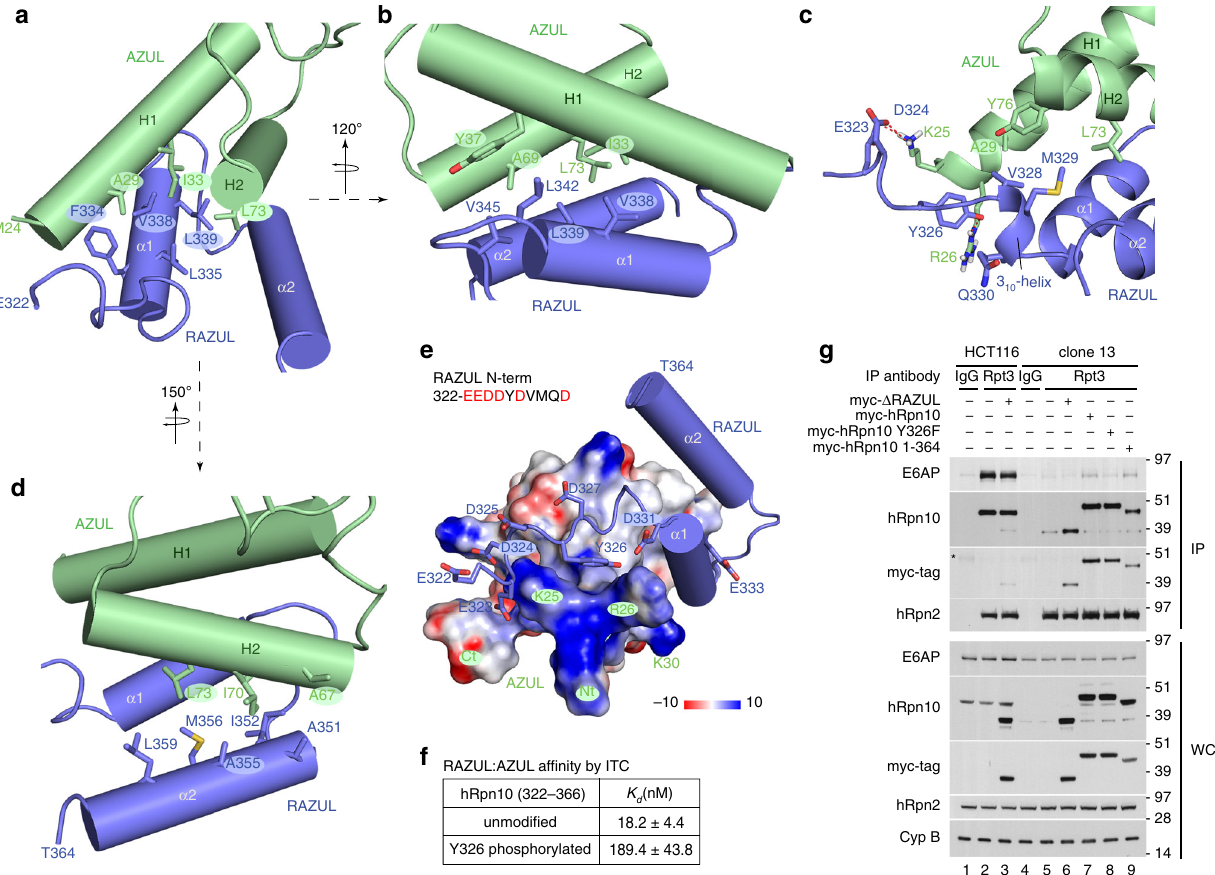
Fig. 6 RAZUL:AZUL forms an intermolecular 4-helix bundle. Regions displaying AZUL contacts with RAZUL α 1 ( a , b ), the 3 10 -helix ( c ), and α 2 ( d ) showing selected interacting sidechain atoms with oxygen, nitrogen, and sulfur colored red, blue, and yellow, respectively. The structure in c is displayed as a ribbon diagram to better view the 3 10 -helix with hydrogen bonds included as red dashed lines. The structures in a , b , and d depict helices as cylinders for simplicity. e Electrostatic surface diagram for AZUL to highlight acidic (red) and basic (blue) regions. The bound RAZUL is displayed with cylindrical helices and sticks for N-terminal acidic residues with oxygen colored red. f ITC analyses for AZUL-binding hRpn10 322 – 366 without or with Y326 phosphorylated. g Immunoprobing of Rpt3 immunoprecipitates or WCE from HCT116 or clone 13 lysates expressing indicated myc-hRpn10 constructs, including with RAZUL ( Δ RAZUL) or the C-terminal 13 residues deleted (1 – 364) or with hRpn10 Y326 substituted with phenylalanine (Y326F). Cyclophilin B (Cyp B) is used as a loading control for WCE samples. Antibodies used for immunoprobing are indicated to the left of each panel. An asterisk “ * ” indicates heavy chain antibody. Source data are provided as a Source Data fi le.